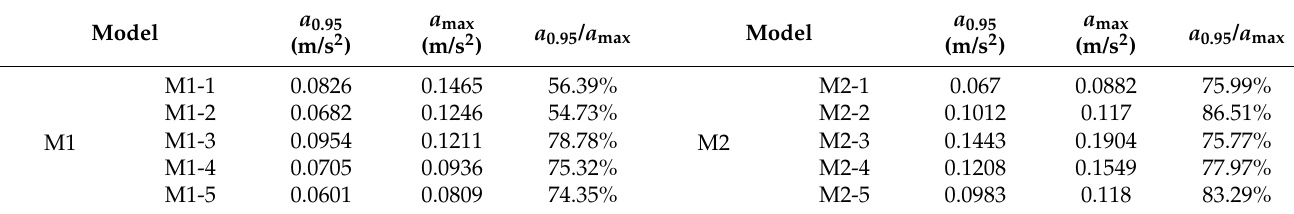
Table 10. Numerical size relationship between different models ( a 0.95 and a max